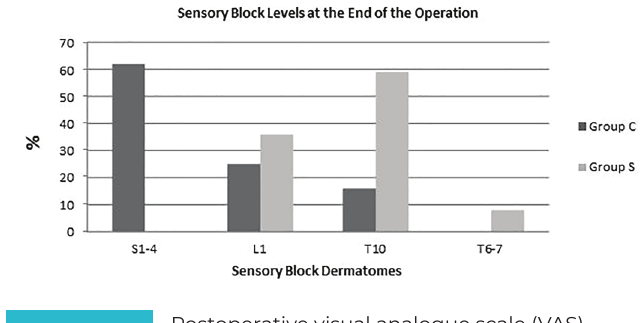
Postoperative visual analogue scale (VAS)